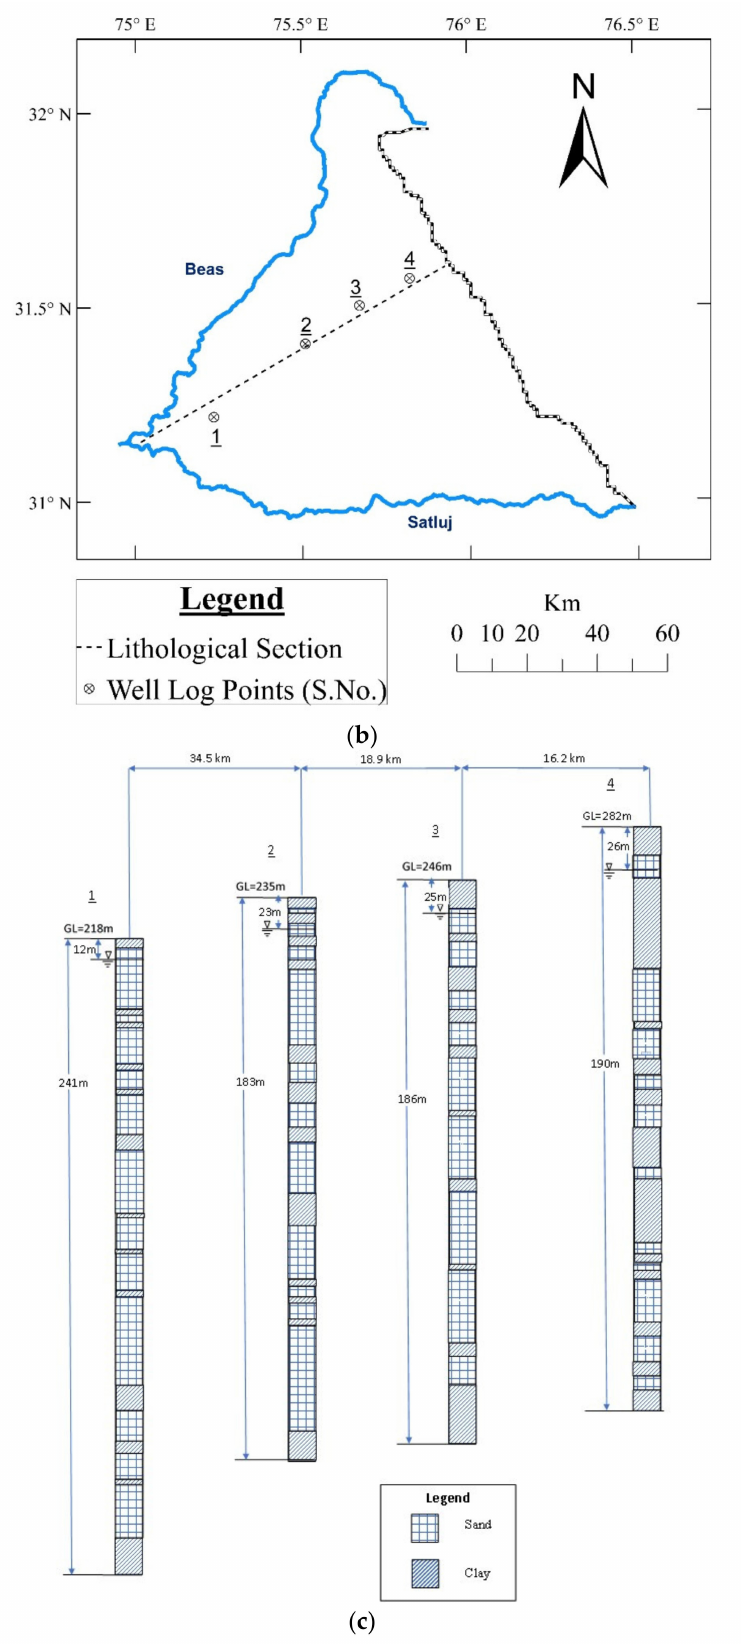
Figure 1. ( a ) Distribution of T sampling points in study area. ( b ) Lithological Section. ( c ) Lithological Profile along the section presented in ( b